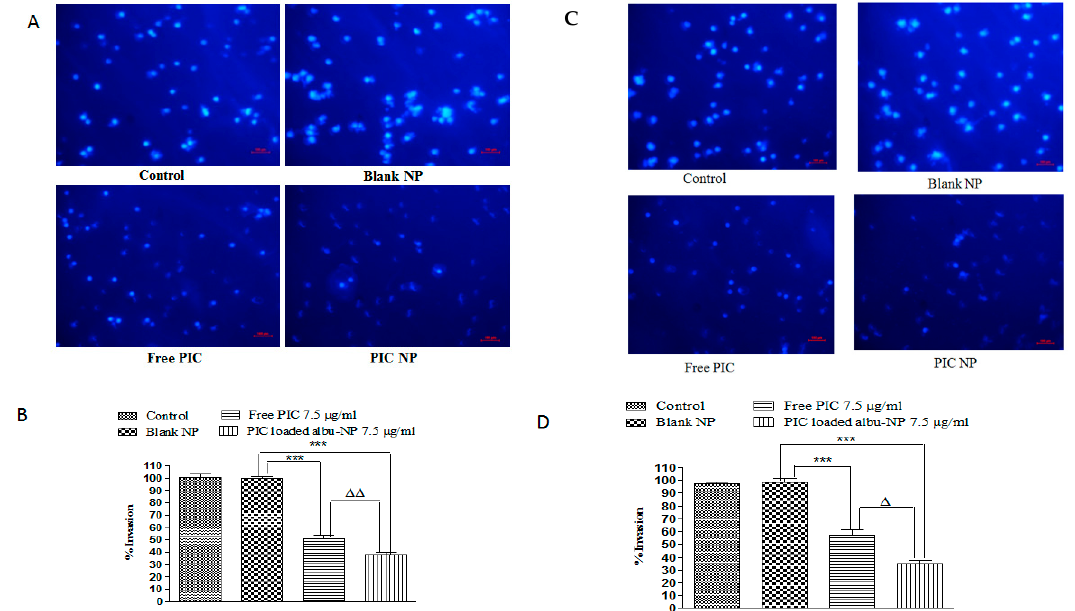
Figure 4. E ff ect of PIC-loaded albumin nanoparticles on invasion potential E ff ect of PIC-loaded albumin NP and free PIC on invasion potential of CaCo-2 cell lines. ( A ) represents anti-invasive activity of free PIC and PIC-loaded albumin NPs after treatment. The cells which appear bright are the ones which invaded through the membrane. PIC-loaded albumin NPs show a significantly ( p < 0.01) lower percentage of invasion than free PIC. ( B ) shows that PIC nanoparticles represent significantly less invasion than free PIC ( p < 0.01). Values are mean ± SEM with n = 3. *** p < 0.001 compared with blank NPs. ∆∆ p < 0.01 compared with the same dose of free PIC. Similarly, ( C , D ) represents anti-invasive activity of free PIC and PIC-loaded albumin NPs after treatment in HT-29 cells. The cells which appear bright are the one swhich invaded through the membrane. ( C ) shows PIC-loaded albumin NPs show a significantly ( p < 0.05) lower percentage of invasion than free PIC. ( B ) shows that the PIC nanoparticles have significantly less invasion than free PIC ( p < 0.05). Values are mean ± SEM with n = 3. *** p < 0.001 compared with blank NPs. ∆ p < 0.05 compared with the same dose of free PIC.